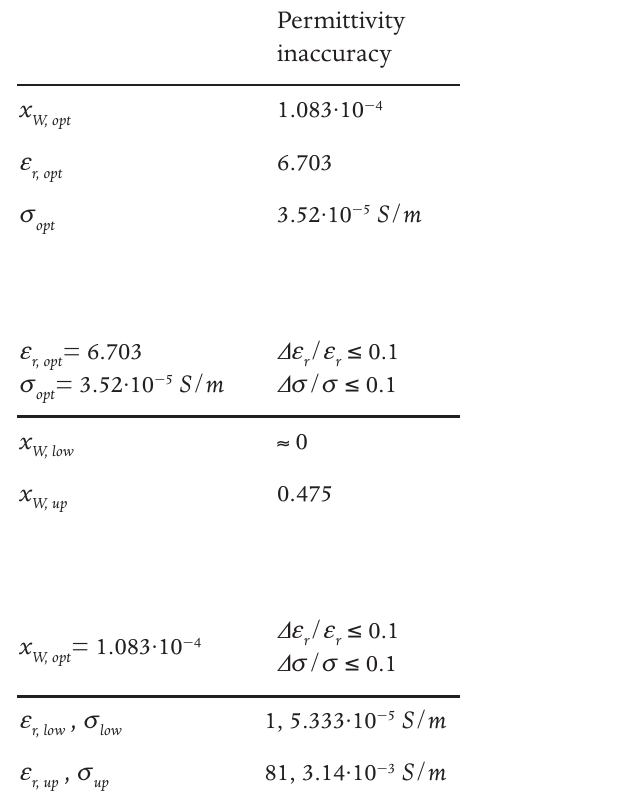
Table 1. Wenner's configuration: (a) optimal point ( x permittivity inaccuracy; (b) range of x where Df once selected optimally f